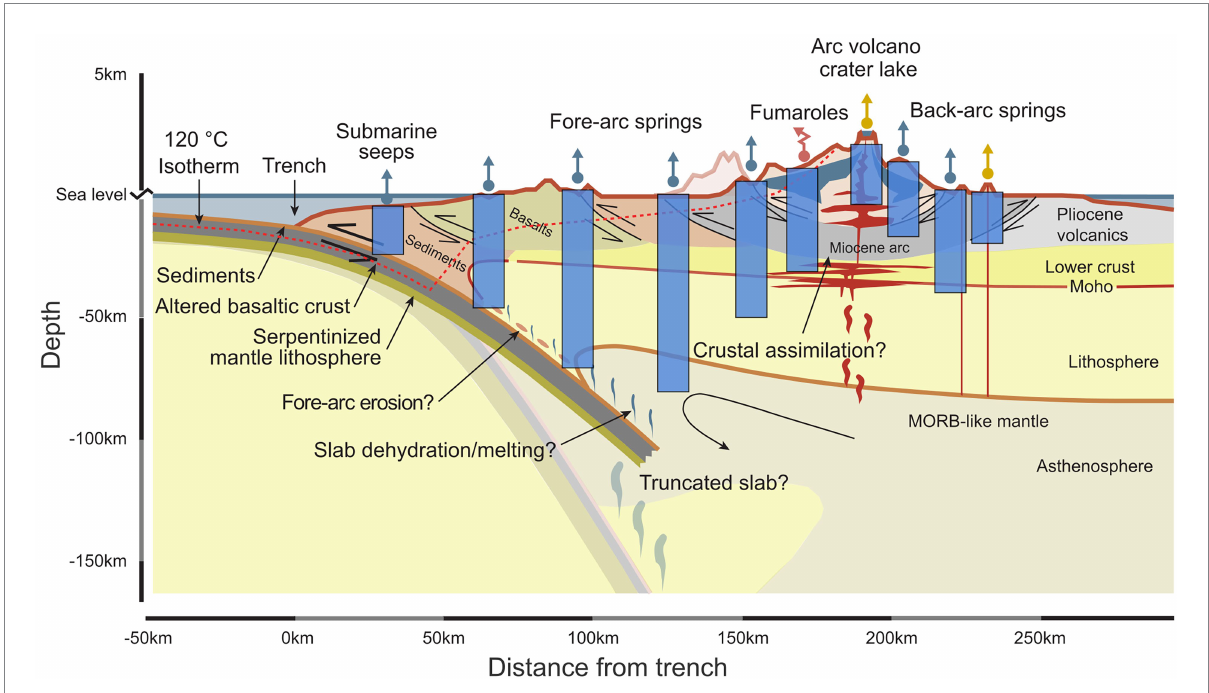
FIGURE 1 Sampling deeply sourced seeps as windows into the subsurface across geological provinces can help to identify biological interactions with large- scale geological processes. Each deeply-sourced seep (represented by a straight upward arrow for fluids, teal for springs, sand for volcanic crater waters, or by a jagged red arrow for gases) gives access to an integrated view of the source and processes occurring at depth (light blue rectangles). Transects across large-scale geological gradients can be obtained using this approach. Modified after Giovannelli et al.